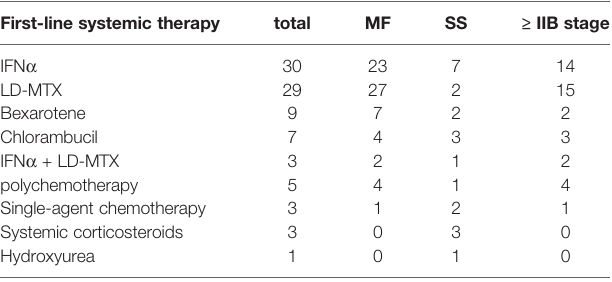
TABLE 2 | Systemic agents used as fi rst-line treatment for patients with MF and SS with or without previous skin directed therapy. First-line systemic